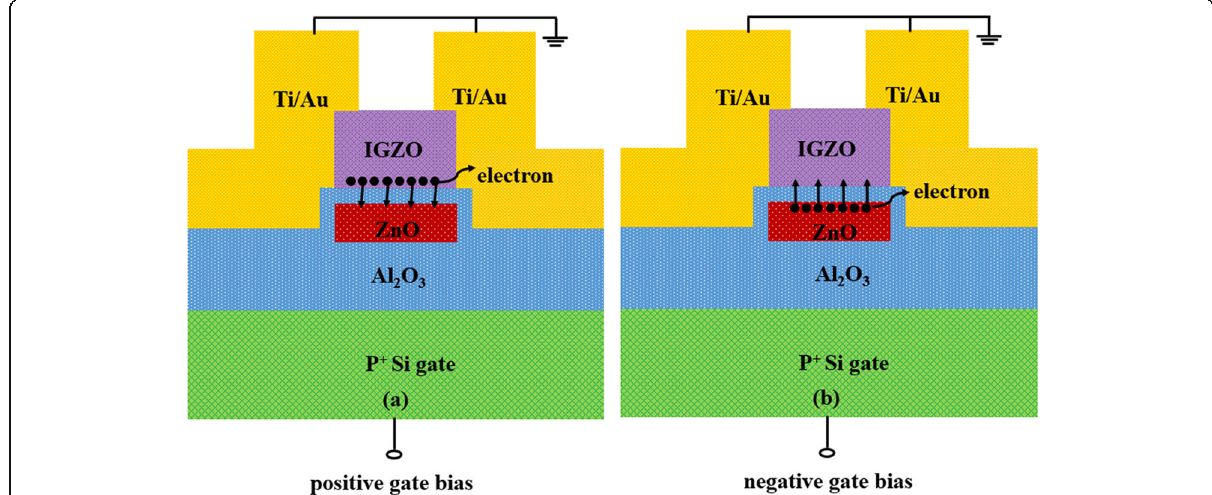
Fig. 1 The cross section schematic diagrams of the a-IGZO TFT memory device programmed under a positive gate bias ( a ) and a negative gate bias ( b ),